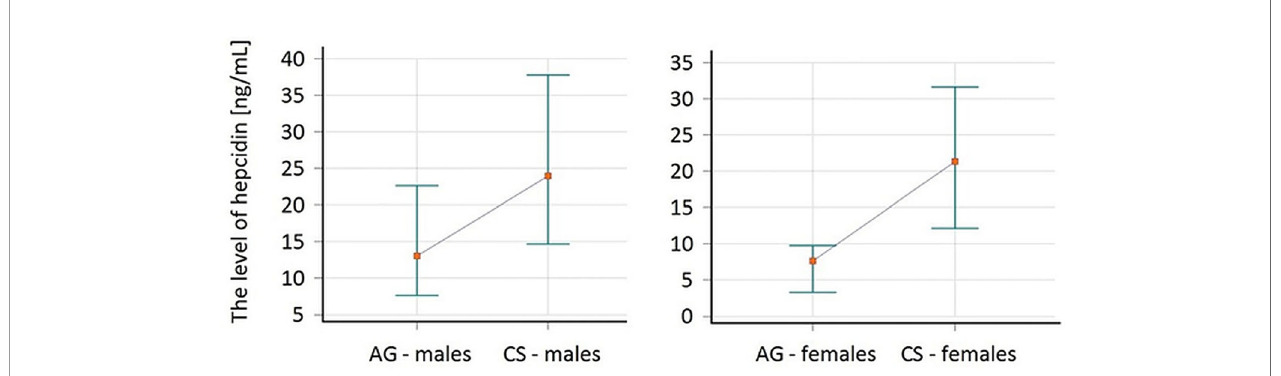
FIGURE 2 | The comparison of hepcidin level in patients with acromegaly (AG) at the time of the diagnosis and in the control subjects (CS) divided by gender. Values are expressed as median and interquartile range (IQR).